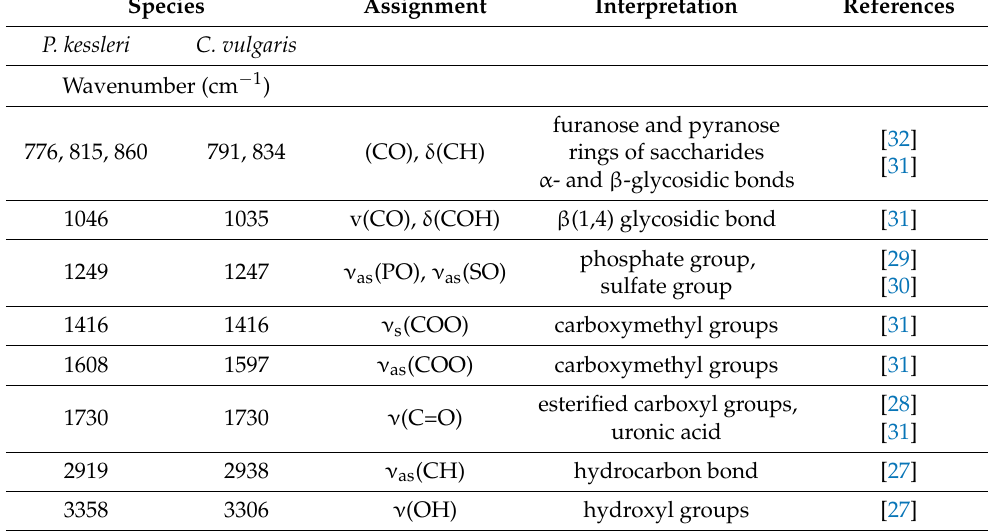
Table 6. FTIR band assignment for the EPS of P. kessleri and C. vulgaris . Species Assignment